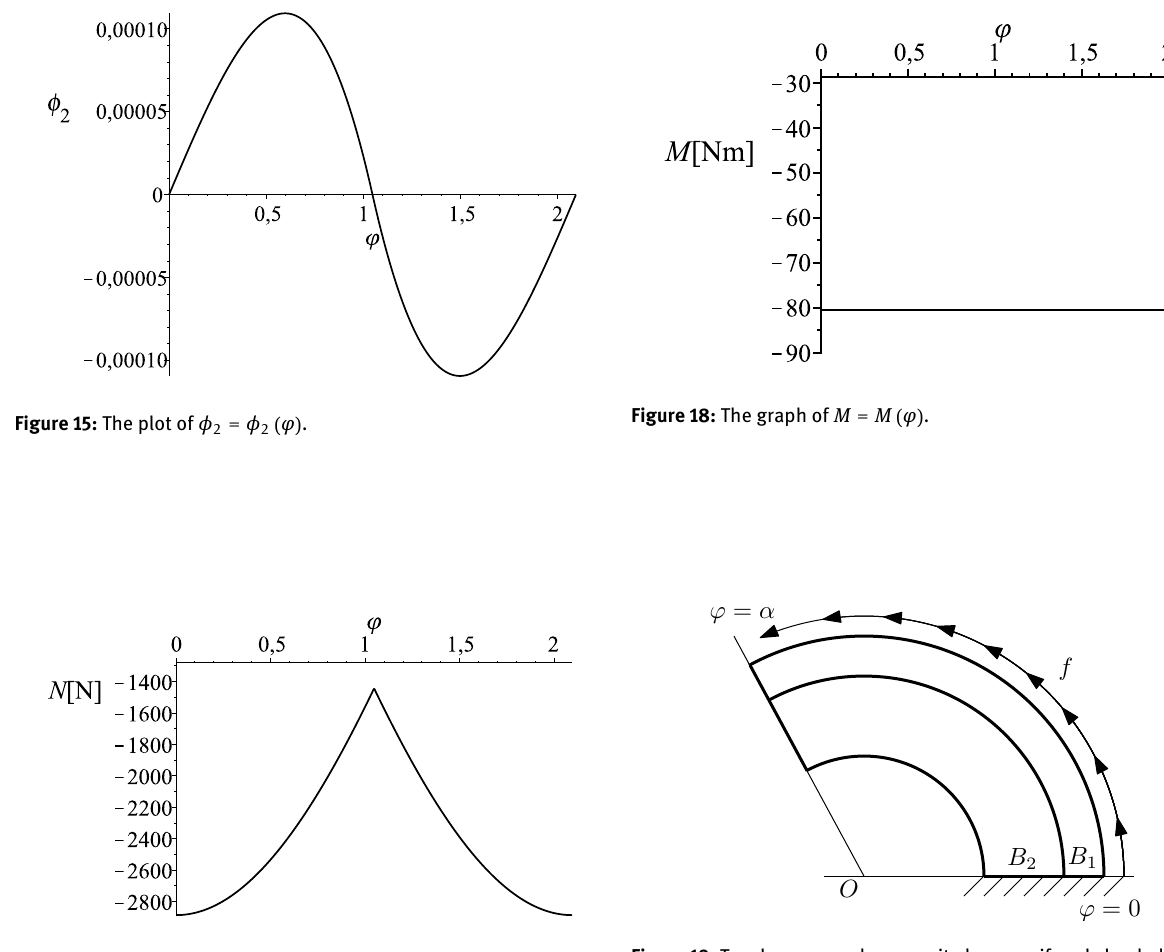
Figure 16: The graph of normal force function.